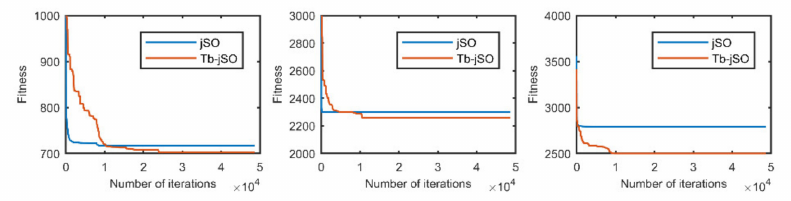
Figure 11. The selected average convergence of jSO and Tb-jSO is compared on CEC2020 in 15 D . From left to right f3, f8 and f9.